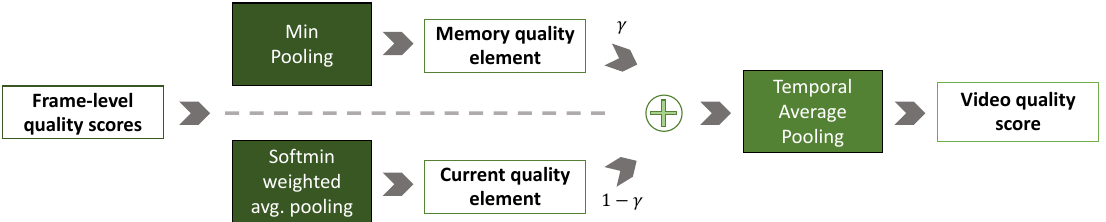
Figure 3. Temporal Hysteresis Pooling [11]. This pooling layer addresses the problem of overestimating the quality of videos. Specifically, a Memory quality element is defined as the minimum of the quality scores over the previous frames, while a Current quality element is defined as a sort-order-based weighted average of the quality scores over the next frames. The approximate score is then calculated as the weighted average ( γ ) of the Memory and Current elements. The overall video quality is finally computed as the temporal average pooling of the approximate